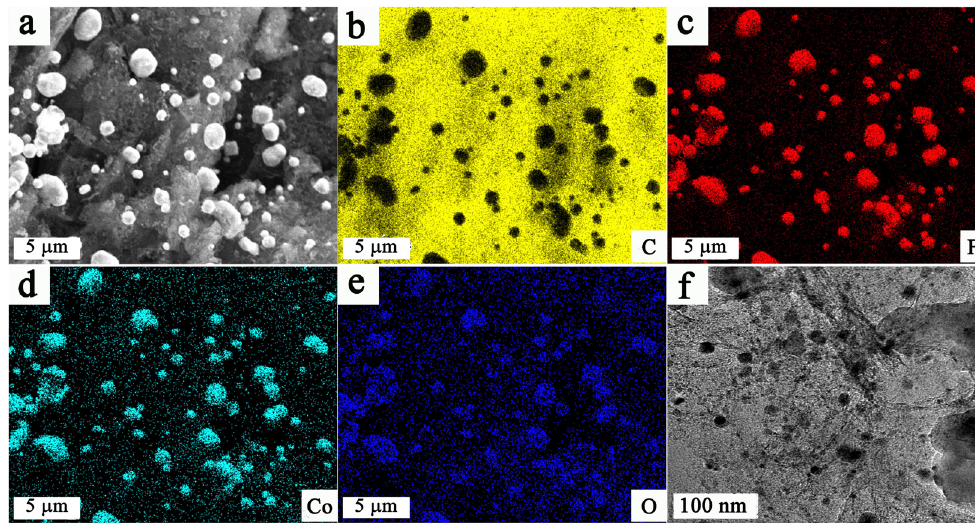
Figure 2: ( a ) SEM image and ( b – e ) elemental mapping of C, Fe, Co, O of CoFe 2 O 4 @BC. ( f ) TEM image of CoFe 2 O 4